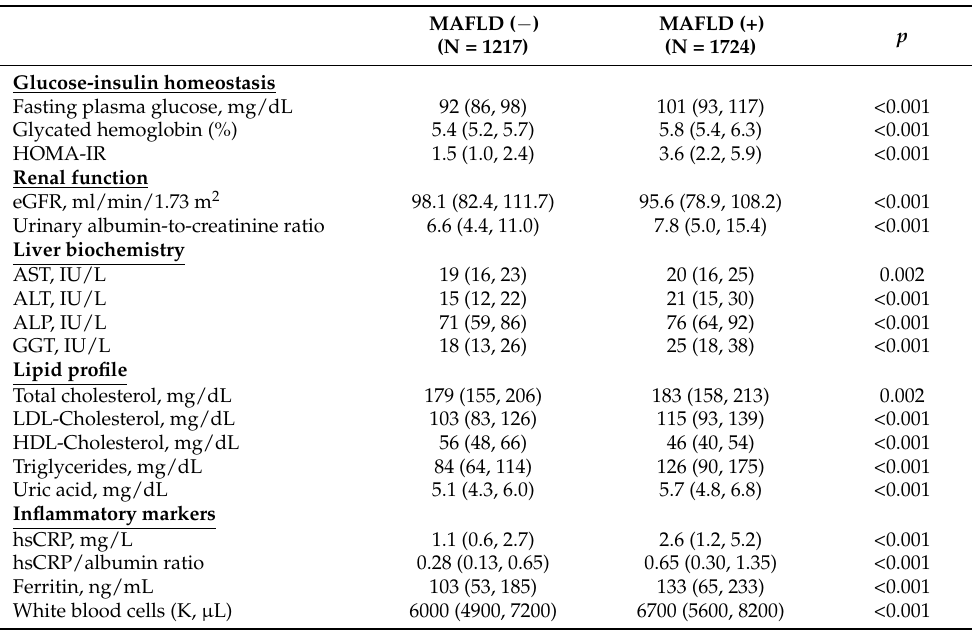
Table 2. Differences in laboratory markers according to the presence of metabolic dysfunction- associated fatty liver disease